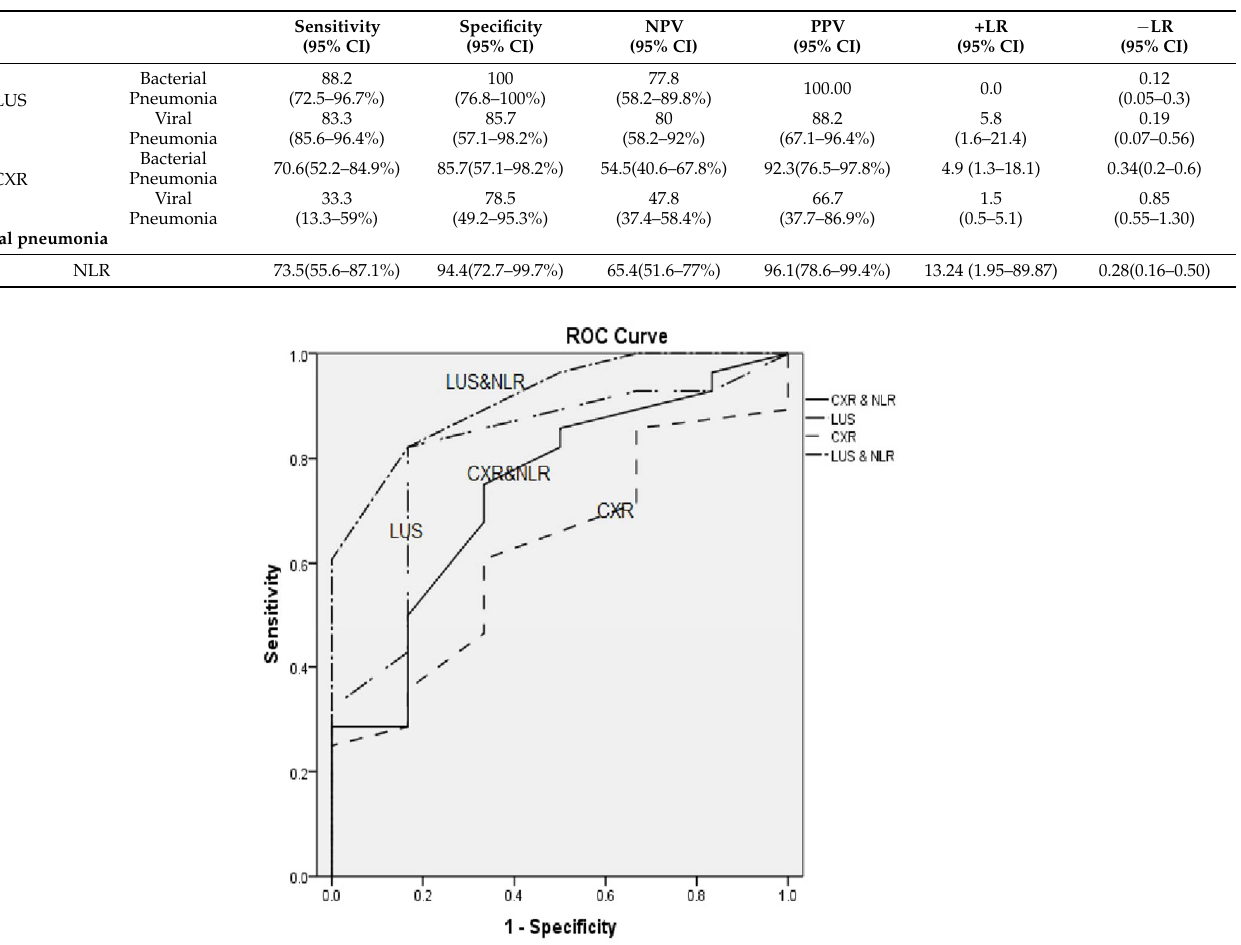
Table 3. Diagnostic performances of LUS, CXR and NLR.